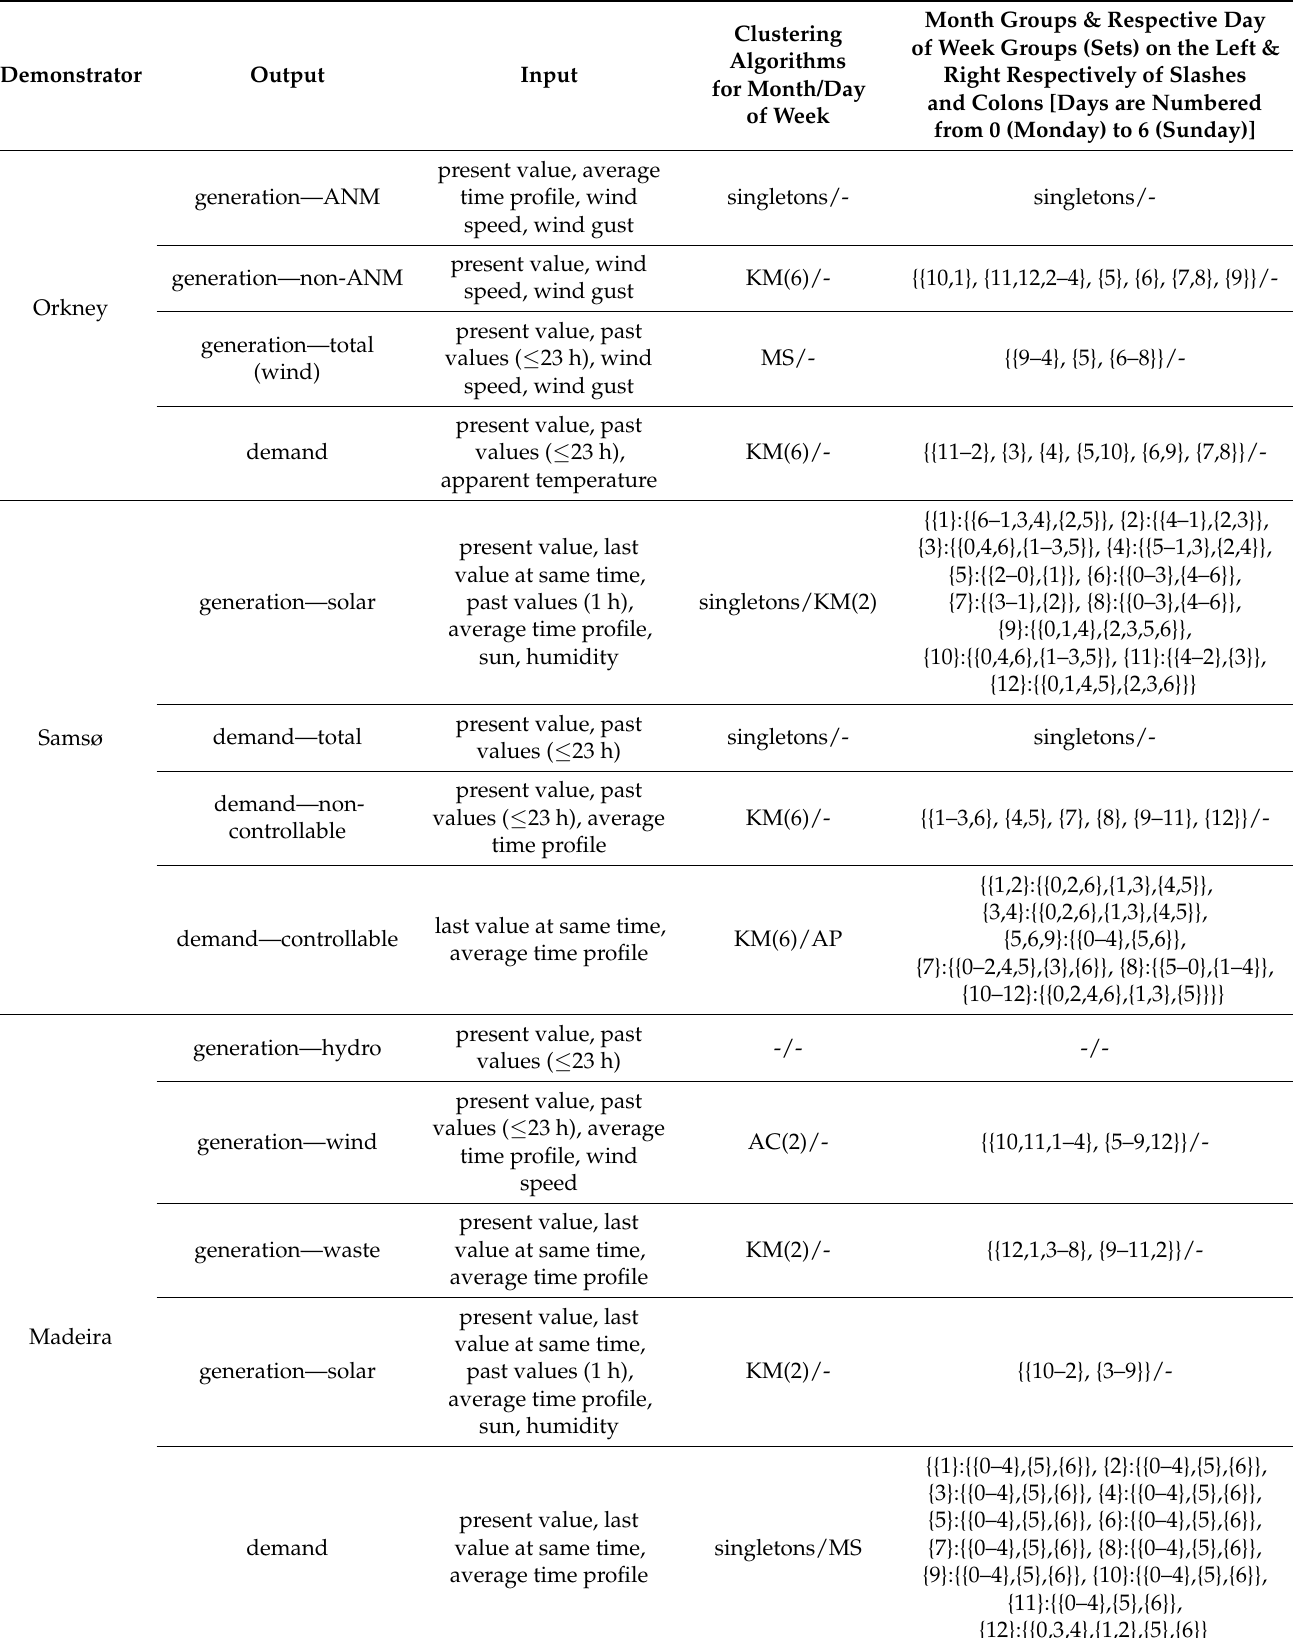
Table 2. Input variables selected and clustering details regarding the forecasting